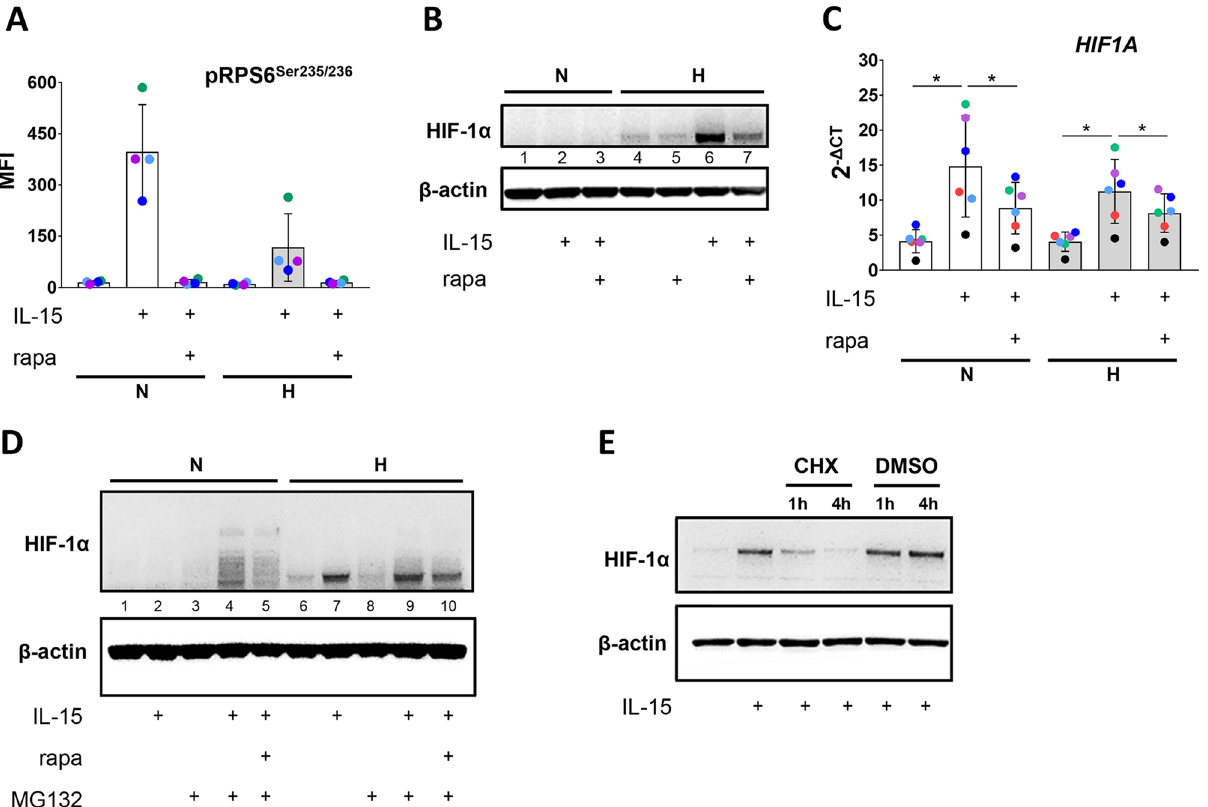
Figure 1. IL-15 priming induces HIF-1α production only partially through mTORC1. ( A – D ) NK cells were incubated under normoxia (N, 21% O 2 ) or hypoxia (H, 1% O 2 ) for 16 h, primed with IL-15 for additional 6 h in the presence or absence of rapamycin (rapa) and the proteasome inhibitor MG132 as indicated. ( A ) Bead array analysis of pRPS6 Ser235/236 . Median fluorescence intensities (MFI) are represented as mean values ± SD (n = 4). Statistical significance was not reached when applying the Wilcoxon signed-rank test. ( B ) Immunoblotting with antibodies against HIF-1α and β-actin (loading control). The blot reflects one representative experiment of three performed. ( C ) RT-PCR analysis. Linearized quantities (2 −ΔCt ) are represented as mean values ± SD (n = 6). * p < 0.05, Wilcoxon signed-rank test. ( D ) Anti-HIF-1α and anti-β-actin immunoblot analysis. The blot reflects one representative experiment of two performed. ( E ) NK cells were incubated for 4 h with DMOG (chemical hypoxia) and with or without IL-15. Where indicated, cytokine-treated cells were cultured for additional time periods with cycloheximide (CHX) or vehicle (DMSO). Cultures were subjected to anti-HIF-1α and anti-β-actin immunoblot analysis. The blot reflects one representative experiment of three